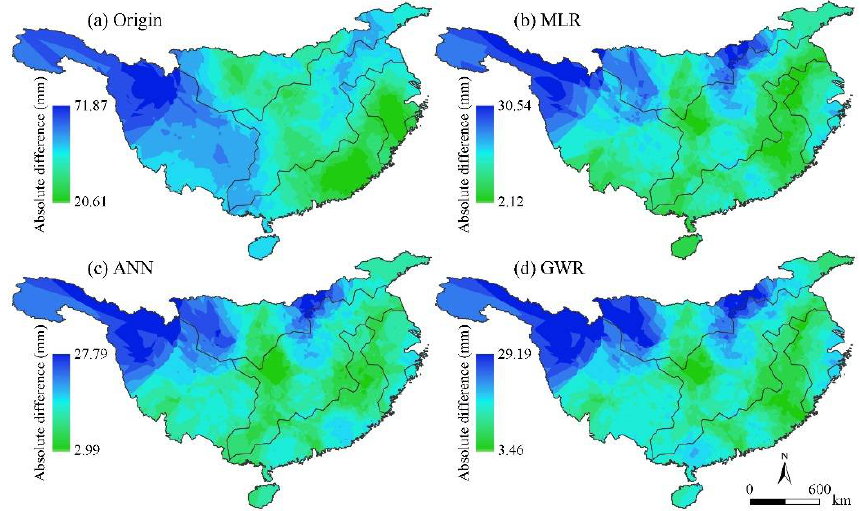
Figure 8. Spatial distribution of the absolute precipitation difference between the ( a ) original product and three correction products (( b ) MLR, ( c ) ANN, and ( d ) GWR).